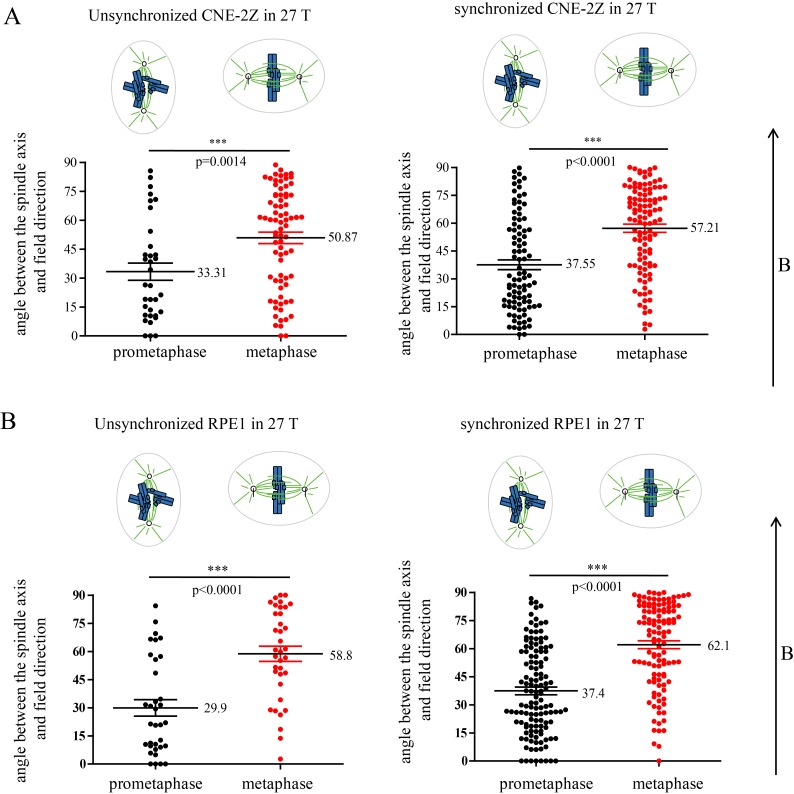
Prometaphase and metaphase cells show different orientation in both synchronized and unsynchronized CNE-2Z and RPE1 cells after 27 T SMF exposure for 4 hr.Quantification of prometaphase and metaphase spindle orientations in 27 T treated CNE-2Z (A) and RPE1 (B) cells from four independent coverslips from an unsynchronized or synchronized experiment. One dot represents one spindle. Data is mean ± SEM. ***p<0.005.